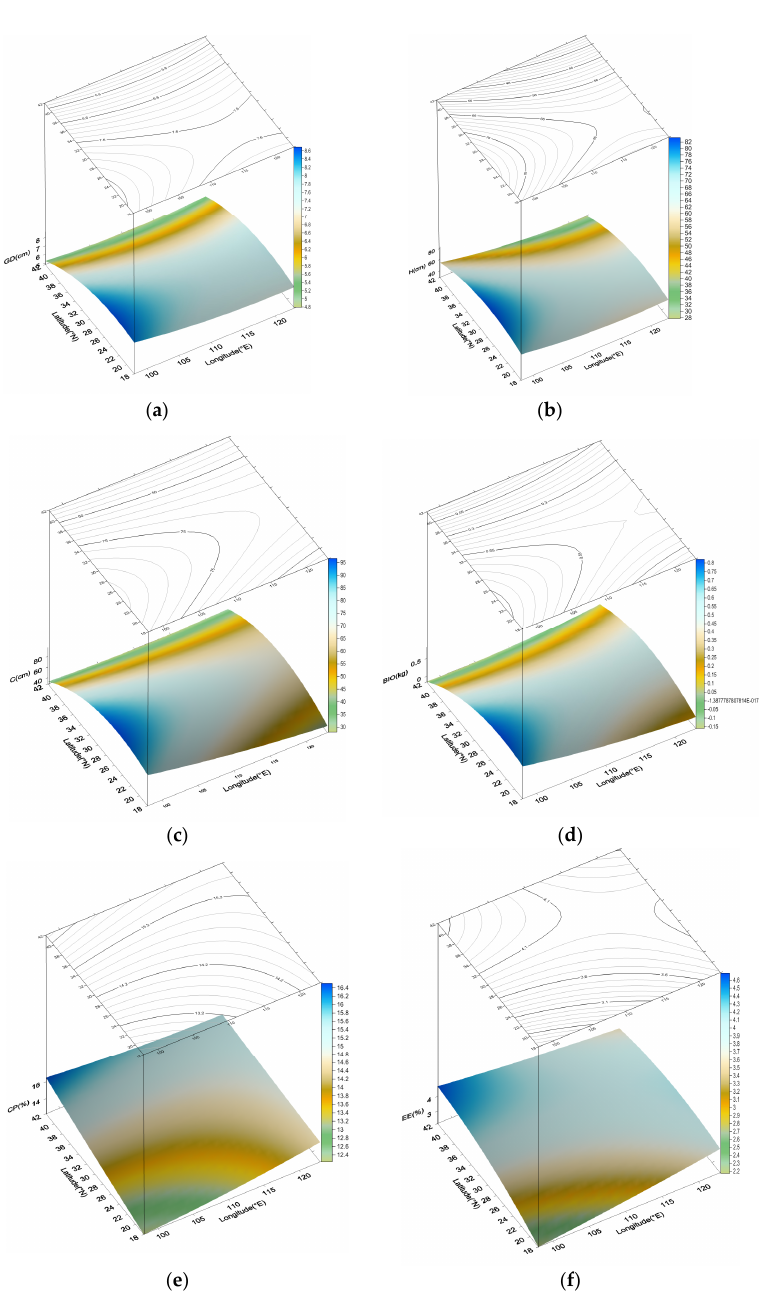
Figure 2. Power contour-trend surfaces for the GD ( a ), H ( b ), C ( c ), Bio ( d ), CP ( e ), and EE ( f ) of B. papyrifera . The surface represents the geographic variation and the lines upon the surface represent the contours.